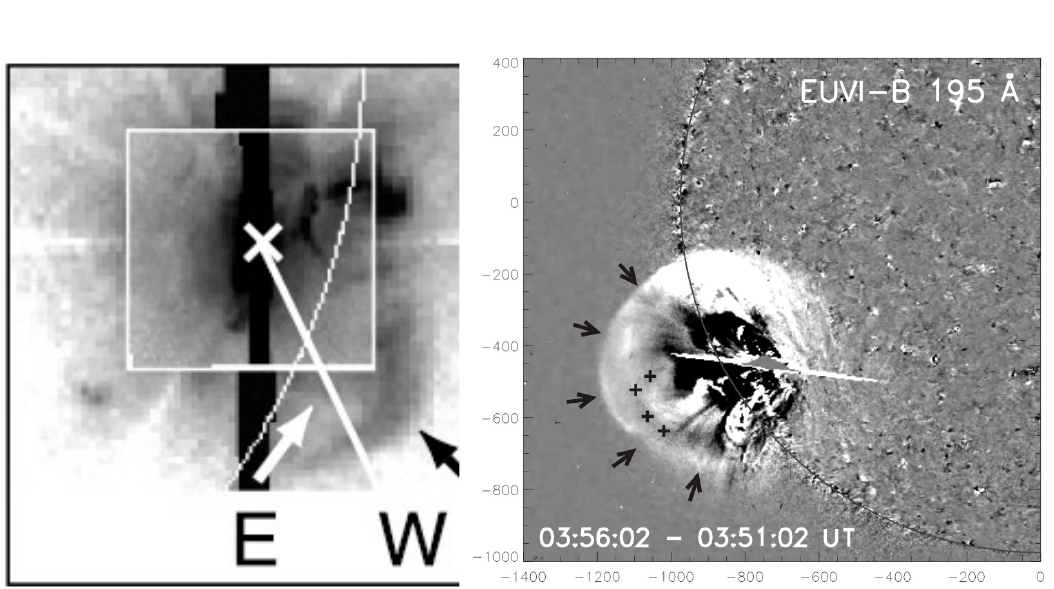
Figure 19: Coronal waves showing full quasi-circular wave domes. Left : The limb wave event of 2000 Mar 3 observed by Yohkoh/SXT. A base image with reversed color table is shown. Note that the wave ( W ) is followed by ejecta ( E ). (Adapted from Narukage et al. , 2004). Right : The coronal wave of 2010 Jan 17 observed with STEREO/EUVI at 195 ˚A. The difference image shows the wave dome ( arrows ) and the erupting CME loops ( crosses ) inside the dome. Image reproduced with permission from Veronig et al. (2010), copyright by AAS.